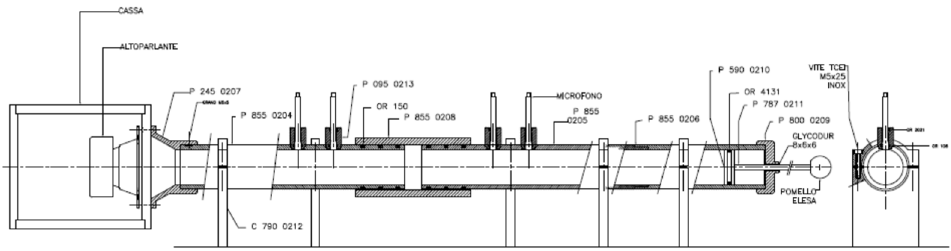
Figure 4. Layout of “Kundt tube” developed in NTT funded research project.